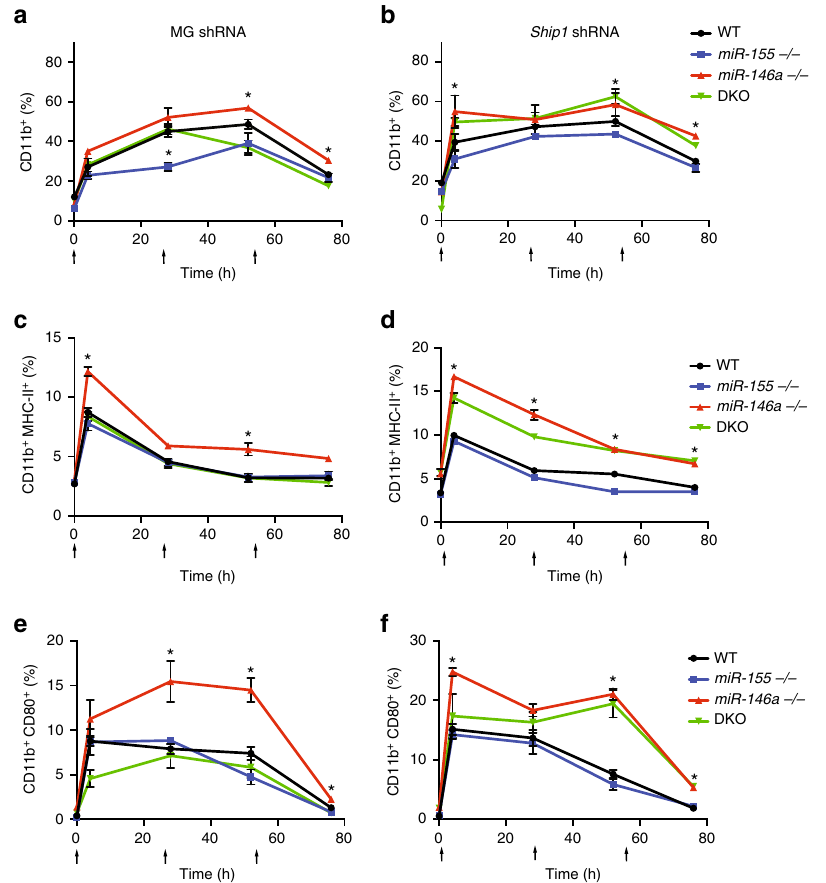
Fig. 5 SHIP1 downregulation restores miR-146a − / − phenotype in DKO macrophages. WT, miR-155 − / − , miR-146a − / − and double knock out (DKO) bone marrow cells transduced with control (MG) (left) or SHIP1 shRNA (right) were reconstituted into recipient mice. Three months after reconstitution, the mice received 1 mg/kg LPS every 24 h for 3 days via IP injections. Peripheral blood macrophage CD11b + percentage ( a , b ), MHC-II high — ( c , d ) and CD80 + ( e , f ) were compared for all strains by FACS analysis. Arrows indicate time of LPS injections. N > 7 per group from two independent experiments, represented as mean ± SEM. * p < 0.05, using two-way